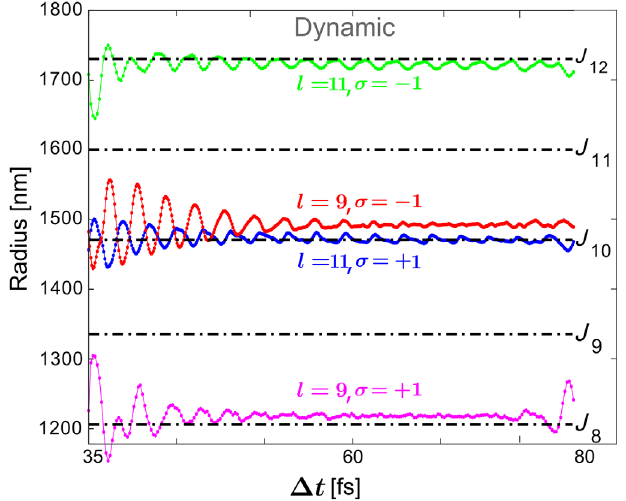
r Þ − J k r Þ ]. 12 ð SPP SPP FIG. 9. Radius of the ωΔ t filtered central pattern in the dynamic region. The horizontal dashed lines represent the radii of the main lobes of the corresponding Bessel functions as in